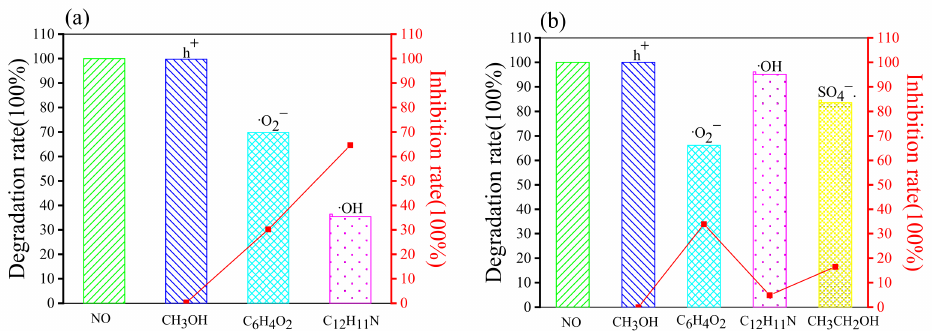
Figure 8. Photocatalytic degradation of Rhb in the synergistic systems with different quenching agents: ( a ) Quenching of Rhb degradation in the H 2 O 2 synergistic system; ( b ) Quenching of Rhb degradation in the Na 2 S 2 O 8 synergistic